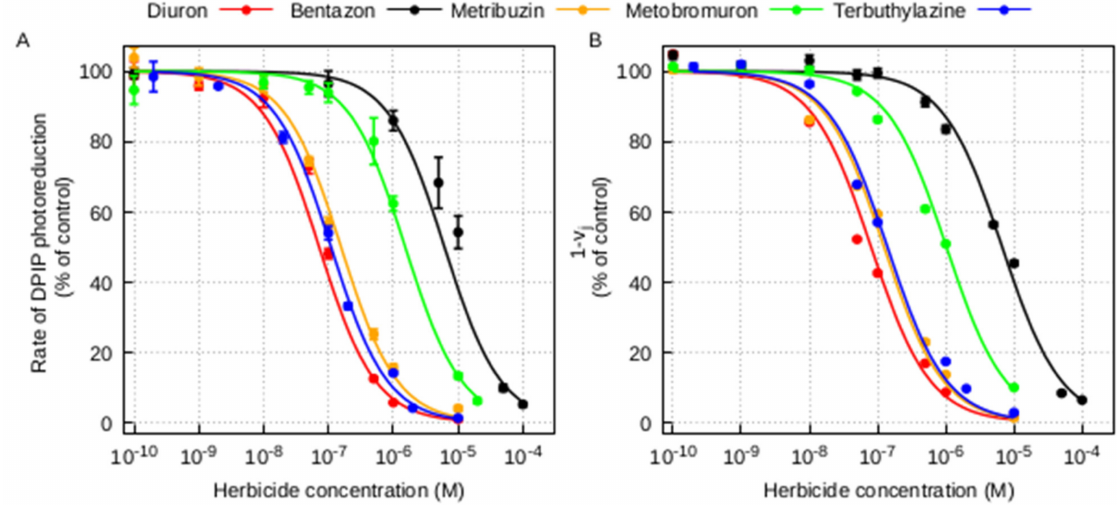
Figure 2. Photochemical and fluorescence assays of Photosystem II inhibition in pea thylakoid membranes by different photosynthetic herbicides. ( A ) Inhibition of DPIP photoreduction. Points are mean of at least three measurements, bars are standard errors. The experimental points were fitted using the Langmuir adsorption isotherm (R 2 = 0.982, R 2 = 0.960, R 2 = 0.996, R 2 = 0.994, R 2 = 0.997 for the fitted inhibition curves with diuron, bentazon, metribuzin, metobromuron and terbuthylazine, respectively). ( B ) Inhibition of the variable fluorescence 1-V j calculated from corresponding OJIP fluorescence transients. Points are mean of at least four measurements, bars are standard errors. The experimental points were fitted using the Langmuir adsorption isotherm (R 2 = 0.989, R 2 = 0.994, R 2 = 0.993, R 2 = 0.991, R 2 = 0.993 for the fitted OJIP curves with diuron, bentazon, metribuzin, metobromuron and terbuthylazine, respectively). All the fittings were performed according to